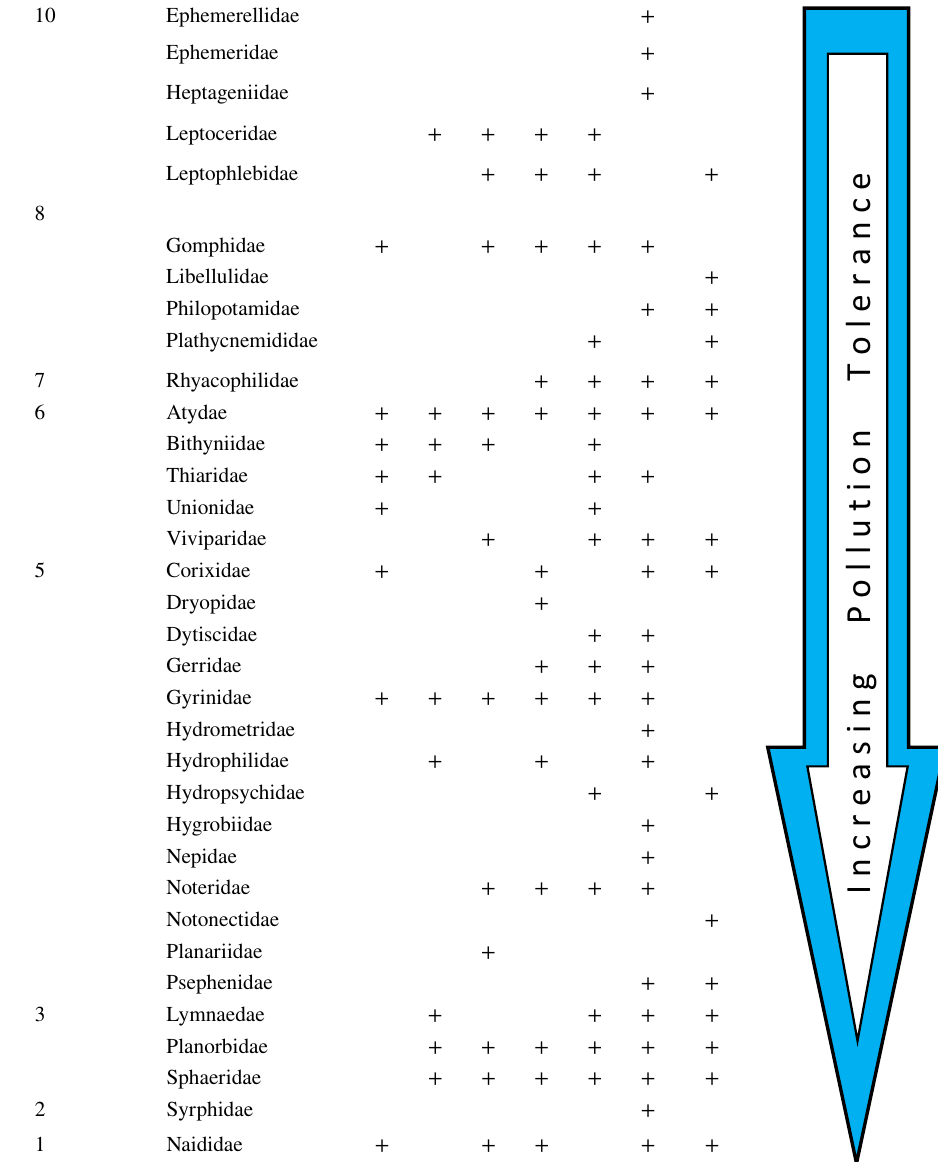
Table 5 Availability of species in the taxonomical families at locations under